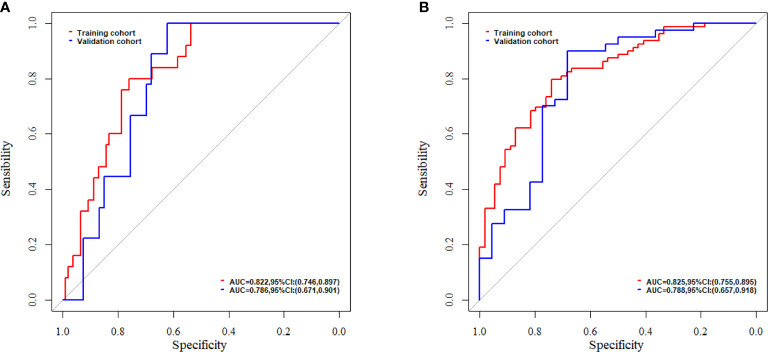
The evaluation of nomogram with receiver operating characteristic curves for (A) short-term survival prediction model; (B) long-term survival prediction model.